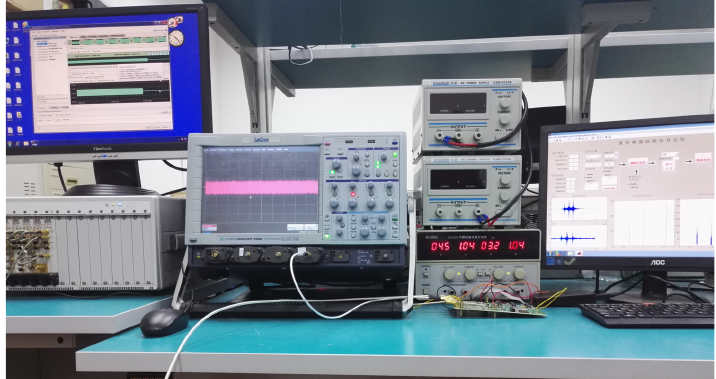
Figure 10. Photograph of the experiment